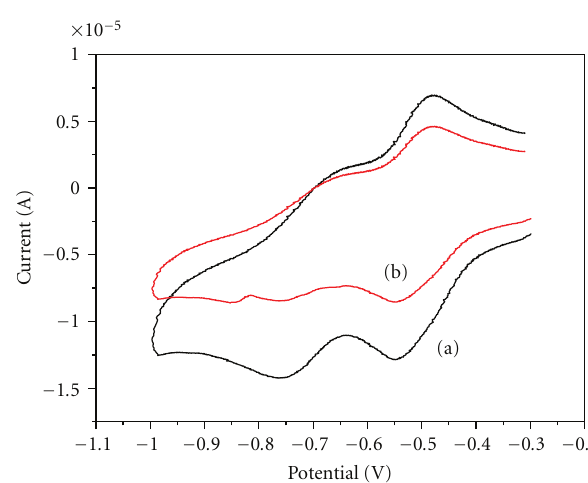
Figure 4: Cyclic voltagramm of 1 ( 0.1mM). (a) in the absence and (b) in the presence of DNA. Supporting electrolyte 0.1 mM TBABF 4 in DMF.